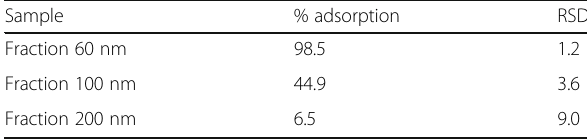
Table 5 Percentage of tin in different-sized silica